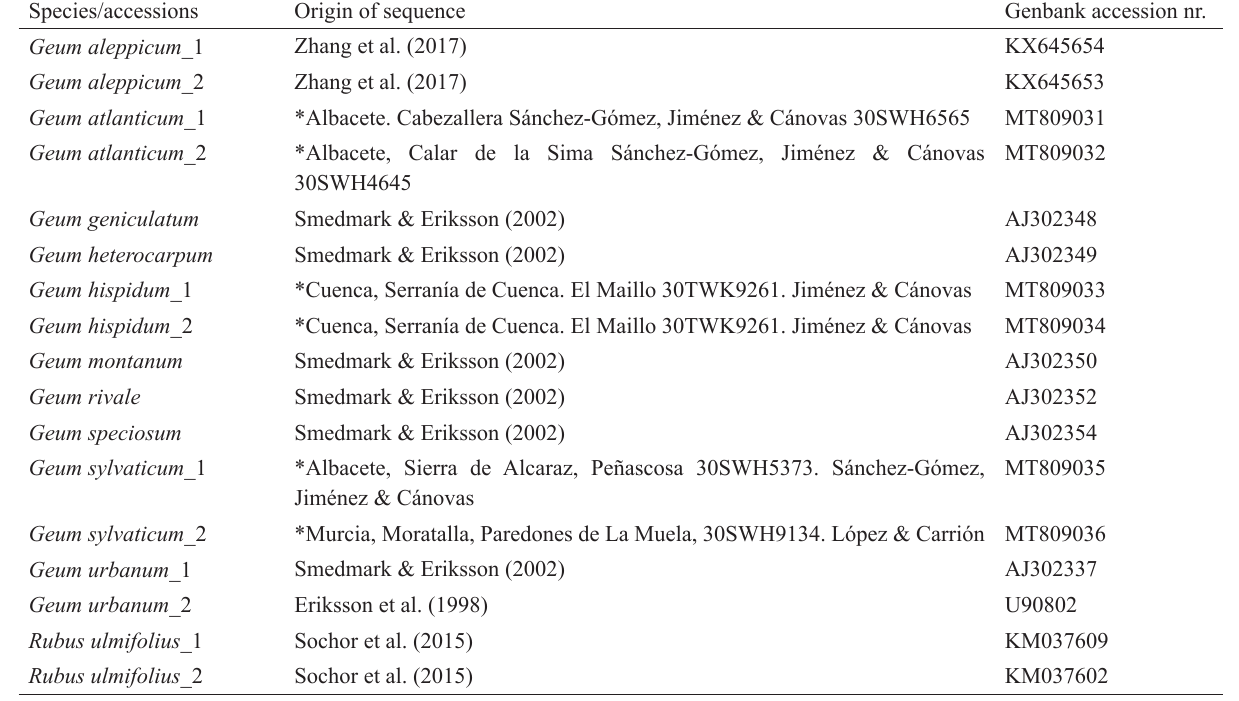
Table 2. Origin of the material included in the molecular analyses, and GenBank accession numbers. Asterisks indicate the accessions used to generate ITS sequence data in the present